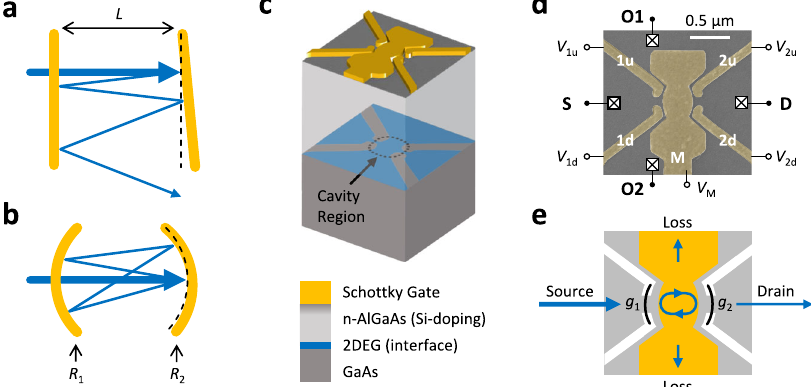
Fig. 1 | Electronic cavity resonator. a The archetypical Fabry – Pérot Inter- ferometer, a plane-parallel resonator, is unstable as a small misalignment allows the rays to leak through the sides. b A stable cavity resonator constructed using concave mirrors provides effective transverse con fi nement through the mirror curvatures. c Electronic cavity resonator fabricated on a GaAs/AlGaAs hetero- structure. Electrons from the Si-doping layer in the n-AlGaAs migrate to the semiconductor interface and form a two-dimensional electron gas (2DEG, blue), where the electrostatic potential is shaped by the Schottky gates on top